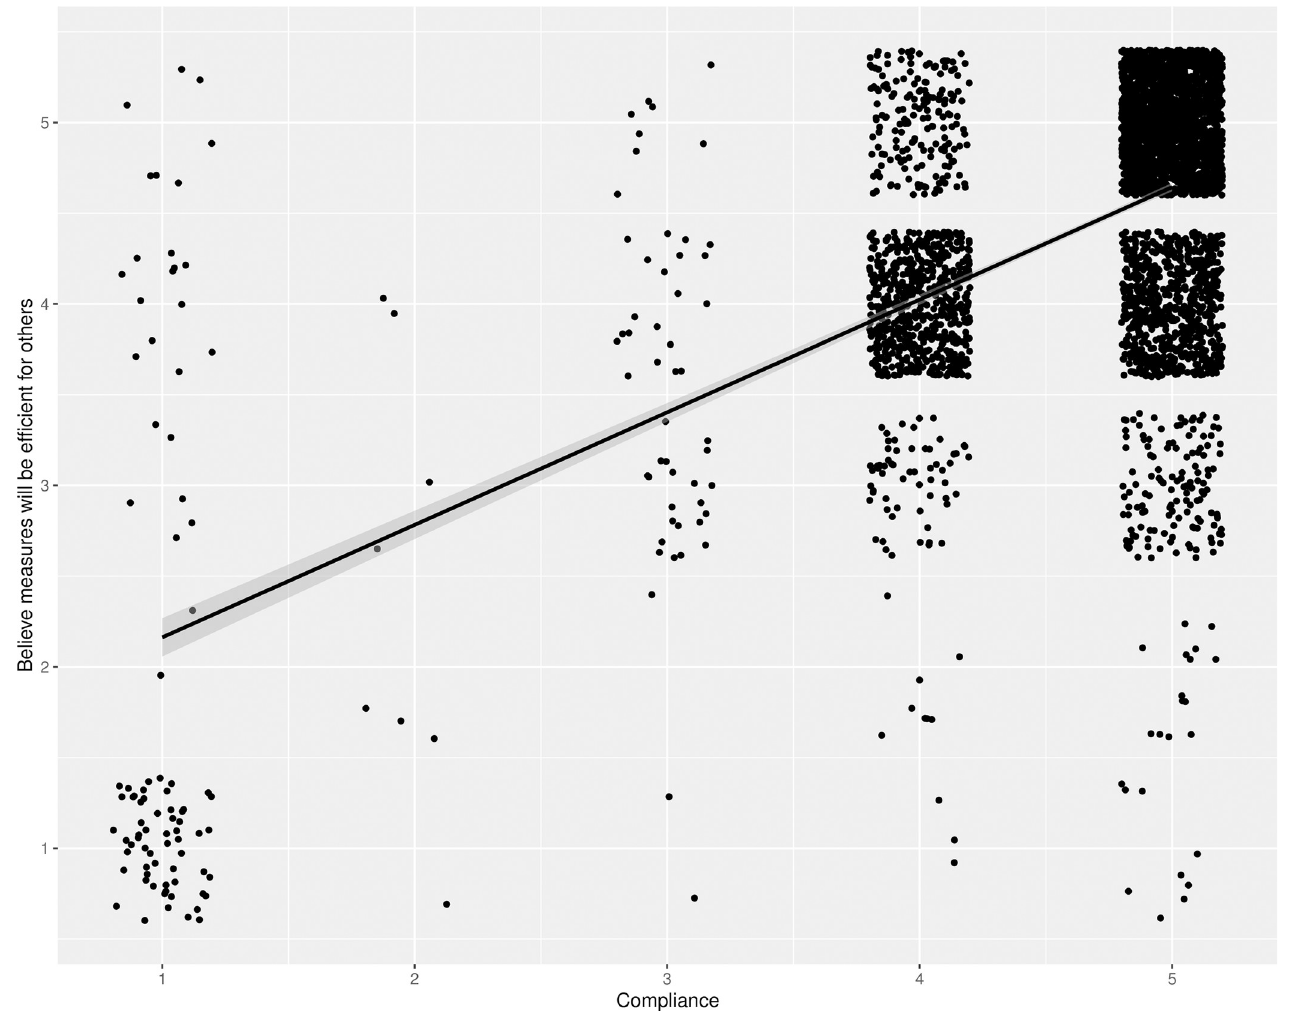
Fig 3. Regression on compliance of believing that measures will be efficient in protecting others. The figure shows the regression line with 95% confidence intervals in grey, corresponding to a test of hypothesis H2, on top of a jittered scatterplot of the responses.